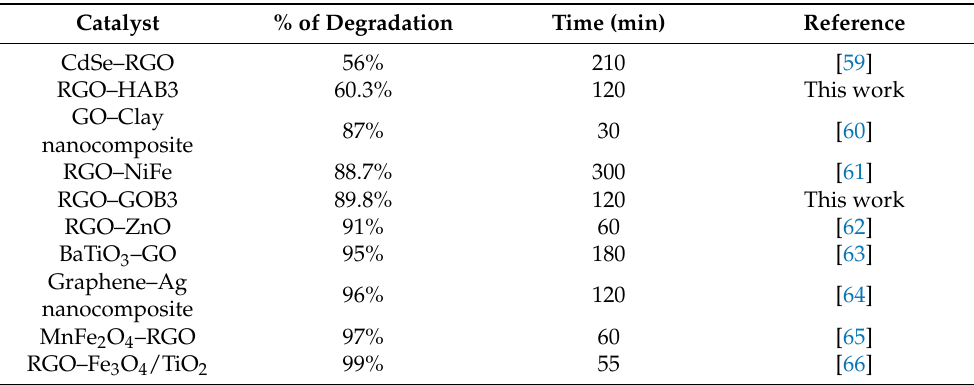
Table 4. Comparison of photocatalysts with their photocatalytic performance against MB dye removal under similar light